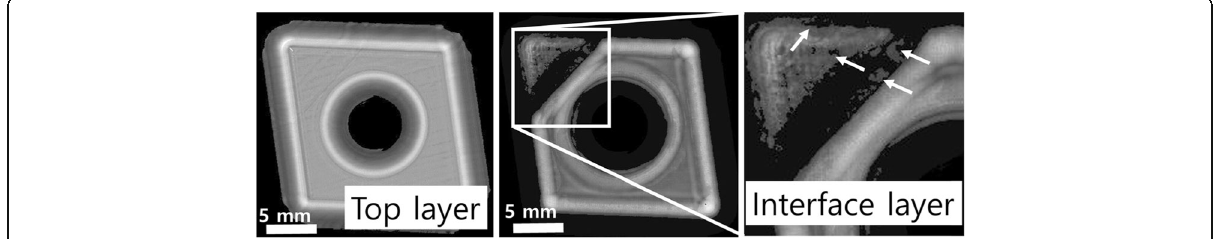
Fig. 4 Images of tungsten carbide inserts obtained from a C-scan using SAM. Incomplete adhesion is indicated by arrows in the image of the interface layer (right) (110 MHz transducer, lateral resolution ~ 15 μ m, 512 px × 512